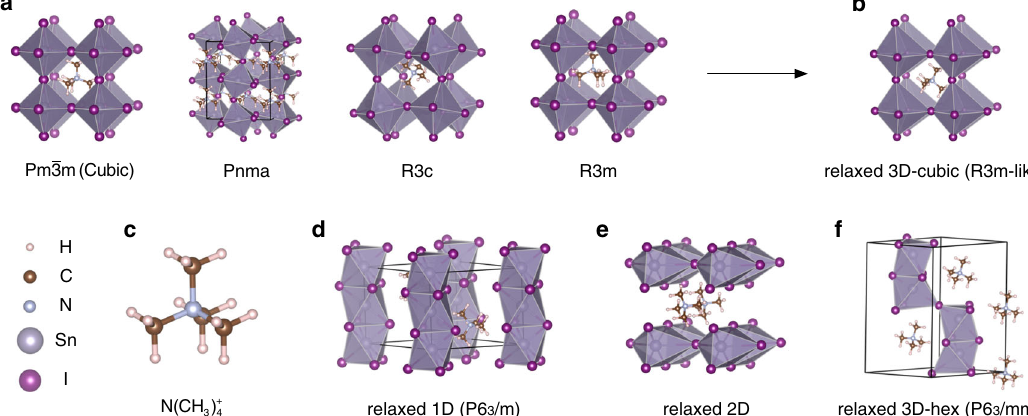
Fig. 1 The initial and relaxed structures of N(CH 3 ) 4 SnI 3 . a The initial 3D-cubic structures with symmetry Pm (cid:1) 3 m , Pnma , R3c , and R3m . b The relaxed 3D- cubic structure from the initial ones in a . c The organic molecule N(CH 3 ) 4 + located at A site. d The relaxed 1D ( P6 3 /m ) structure which represents the experimental structure at the ambient pressure. e The relaxed 2D structure and f the relaxed 3D-hex ( P6 3 /mmc )